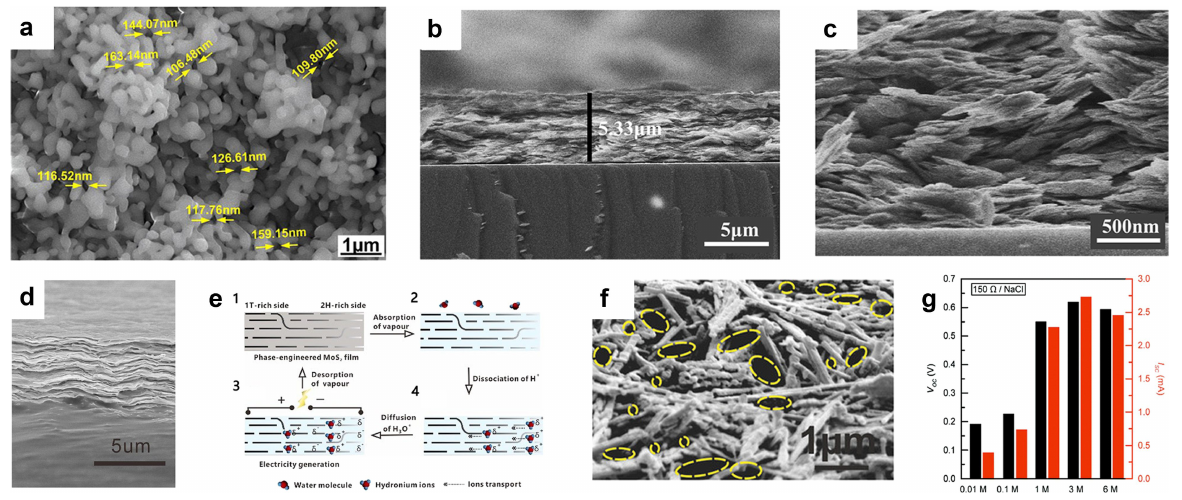
Figure 4: (a) Surface morphology of an Al 2 O 3 layer. Figure 4a was reprinted with permission from [49], Copyright 2021 American Chemical Society. This content is not subject to CC BY 4.0. (b, c) Cross-sectional SEM images of a Ni–Al LDH film. Figure 4b and 4c were adapted from [52]. This article was published in Nano Energy, vol. 70, by J. Tian; Y. Zang; J. Sun; J. Qu; F. Gao; G. Liang, “Surface charge density-dependent performance of Ni–Al layered double hydroxide-based flexible self-powered generators driven by natural water evaporation“, article no. 104502, Copyright Elsevier (2020). This content is not subject to CC BY 4.0. (d) A cross-sectional SEM image of the phase-engineered MoS 2 film with a film thickness of 4.6 µm. (e) The adsorption and desorption process of ions under the phase gradient of MoS 2 . Figure 4d and 4e were reprinted from [50]. This article was published in Nano Energy, vol. 81, by D. He; Y. Yang; Y. Zhou; J. Wan; H. Wang; X. Fan; Q. Li; H. Huang, “Electricity generation from phase-engineered flexible MoS2 nanosheets under moisture“, article no. 105630, Copyright Elsevier (2021). This content is not subject to CC BY 4.0. (f) SEM image of high porosity TiO 2 nanowire network. Figure 4f was reproduced from [54], Shen, D. et al., “Self-Powered Wearable Electronics Based on Moisture Enabled Electricity Generation”, Adv. Mater., with permission from John Wiley and Sons. Copyright © 2018 WILEY-VCH Verlag GmbH & Co. KGaA, Wein- heim. This content is not subject to CC BY 4.0. (g) Measured V OC and I SC values from the MXenes TEPG (transpiration-driven electrokinetic power generators) with NaCl solutions of various concentrations. Figure 4g was reproduced from [55] (“Towards Watt-scale hydroelectric energy harvesting by Ti 3 C 2 T x -based transpiration-driven electrokinetic power generators“, © 2022 J. Bae et al., published by Royal Society of Chemistry, distributed under the terms of the Creative Commons Attribution-NonCommercial 3.0 Unported License, https://creativecommons.org/licenses/by-nc/3.0/). This content is not subject to CC BY